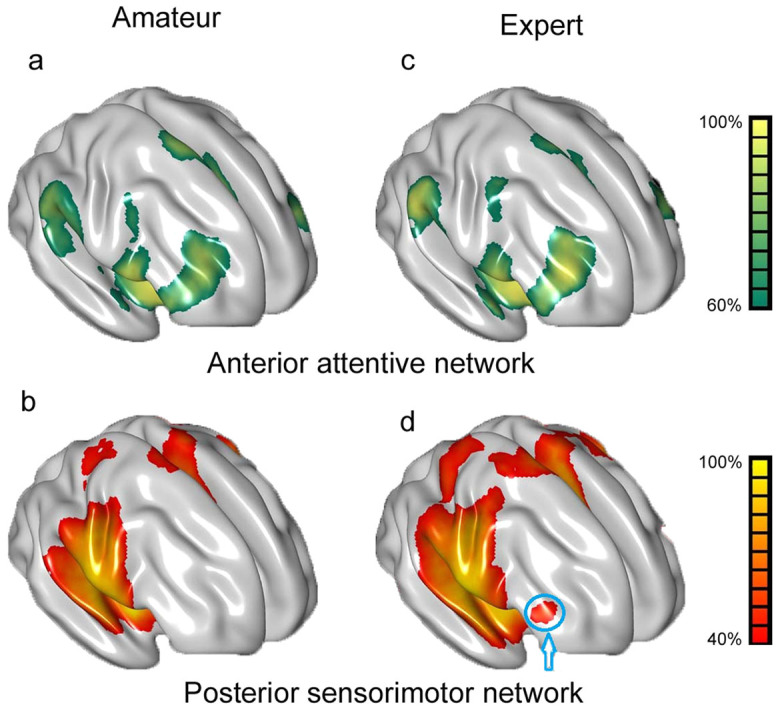
Examples of the A- and P-networks.The left ROI 4 is shown as a representative example in 3a and 3c, and the left ROI 10 is shown as a representative example in 3b and 3d. A spatial distribution similar to the left ROI 4 was observed in the other anterior ROIs, and a spatial distribution similar to the left ROI 10 was observed in the other posterior ROIs. See Supplemental Figure 1 for the analysis of other ROIs. Colours ranging from green to yellow or red to yellow indicate increasing spatial consistency (%). E.g., a 40% value in the amateur group indicates that the relevant brain region was activated in 12 subjects [40% = (12/30) × 100%]. The blue circle indicates the MFG, which is believed to be a key node in the A-network and was also identified in the P-networks of experts. The maps are projected onto a 3D brain surface using the BrainNet Viewer (http://www.nitrc.org/projects/bnv/).